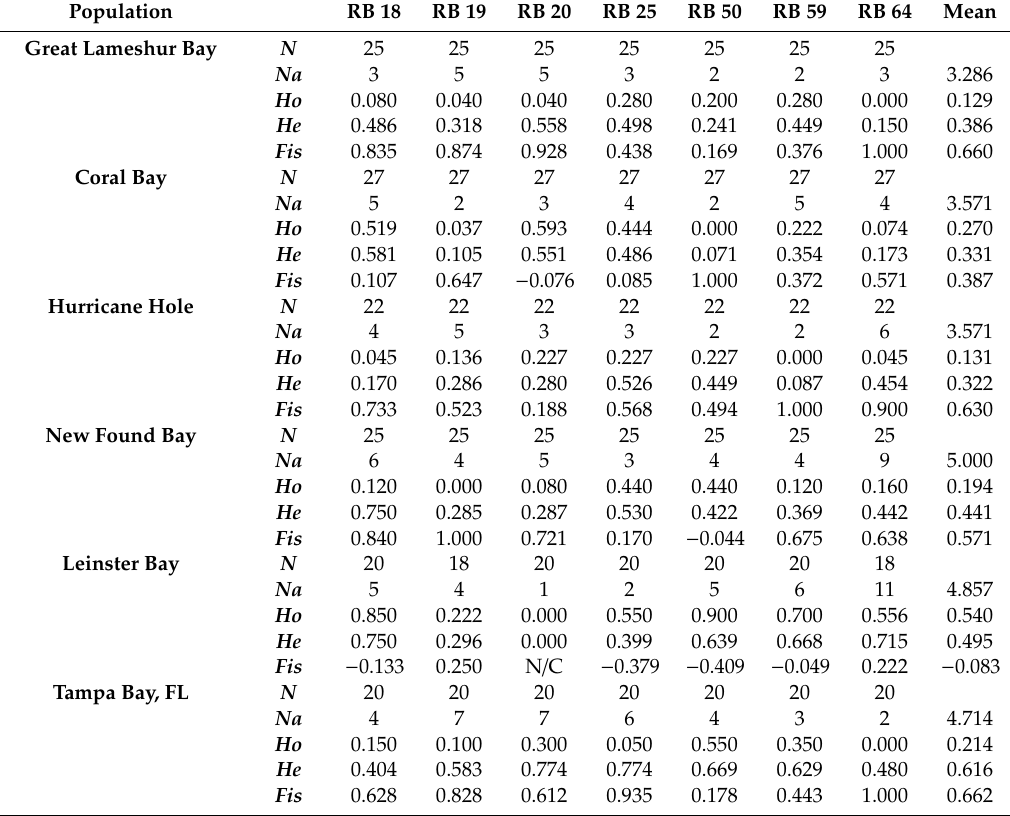
Table 1. Genetic diversity in all of the populations of red mangrove studied. Designated markers reflect RmBra microsatellites with markers identified by their number and abbreviated RB. Na, number of alleles; H o , observed heterozygotes; H e , expected heterozygotes; F IS , coe ffi cient of local inbreeding; and N, numbers of genets employed. N / C = not